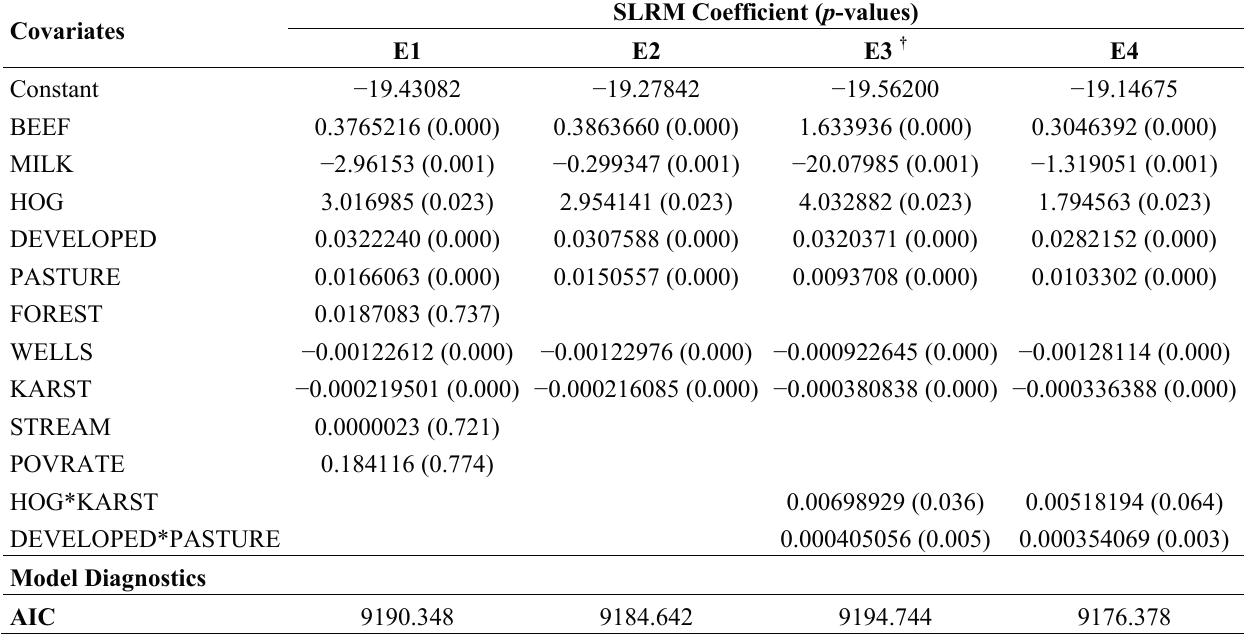
Table 3. Spatial logistic regression model coefficients ( p -values in parentheses) for E. coli O157 individual models. Shaded cells represent excluded variables. Model diagnostics (AIC) are shown in the bottom